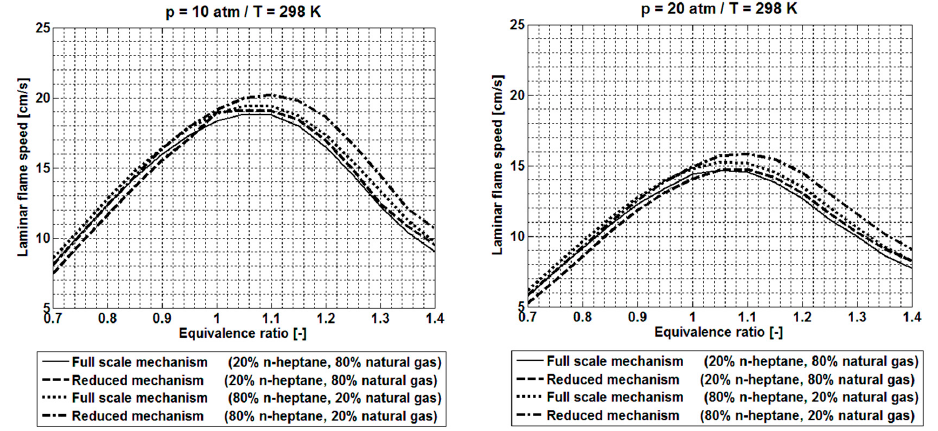
Figure 7. Comparison of laminar flame speed calculations for dual fuel mixtures. The full scale dual fuel mechanism is compared to the reduced mechanism.